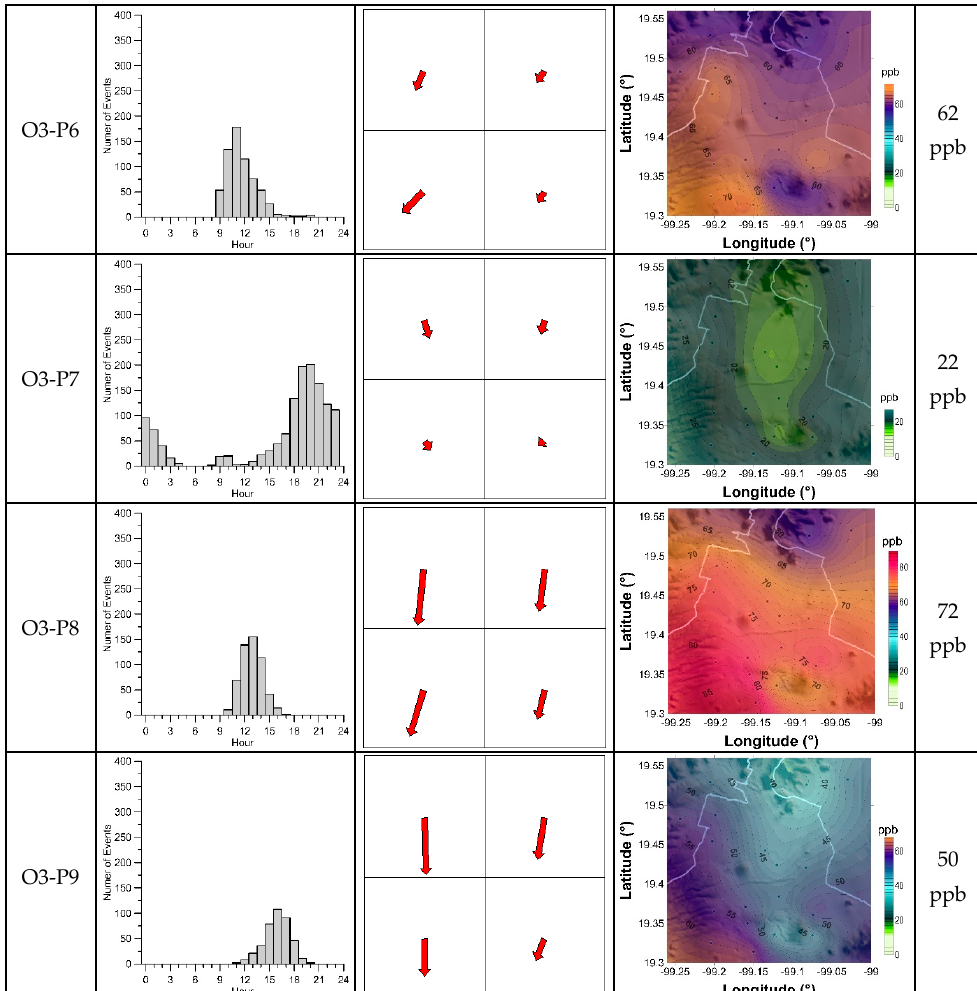
Figure 10. Flow patterns of ozone in the Mexico City region during the period 2001 – 2010. For each flow pattern, the figures show the hourly population (second column), the mean flow vectors (relative to the pattern) at the city quadrants (third column), the surface concentration distributions (fourth column) averaged over the events of the flow pattern, and the mean spatial concentration (last column). The size of red arrows that stand in for the O 3 flow vectors indicates the flow intensity in a scale relative to the edge size of the squares that represent the quadrants.